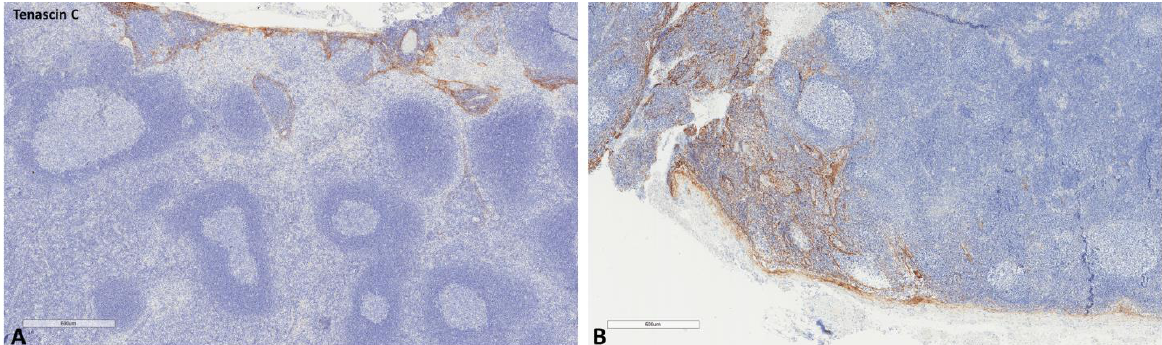
Figure 6. Representative microscopic images of tenascin-C expression in a normal cancer-draining lymph node ( A ) and a normal non-cancer-draining lymph node ( B ).